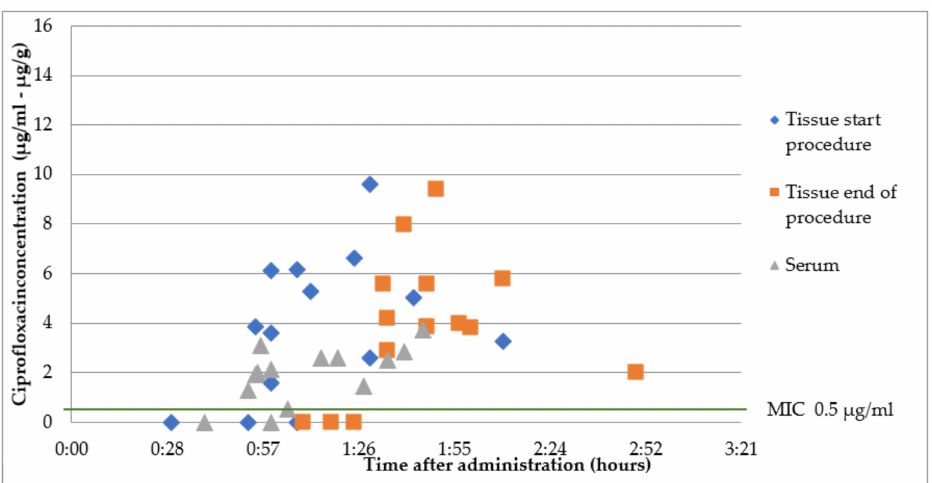
Figure 2. Ciprofloxacin concentrations in serum and prostate tissue after a single oral dose 1 h prior to surgery. Enterobacterales are considered susceptible to fluoroquinolones when MIC < 0.5 µ g/mL